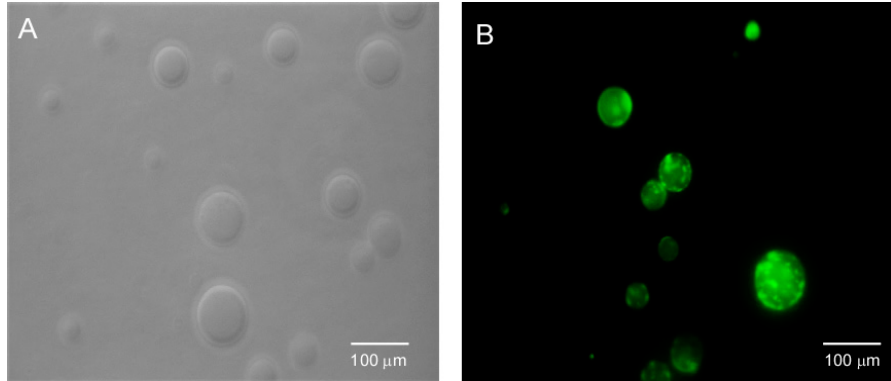
Figure 5. ( A ). Phase contrast image of 1,2-Dioleoyl-sn-glycero-3-phosphocholine (DOPC), giant unilamellar vesicles (GUVs) in absence of HTMA-PFBT. ( B ) Fluorescence microscopy image observed after addition of the polyelectrolyte to the previous sample in different field, recorded upon excitation with Vis-light using the FITR filter set.